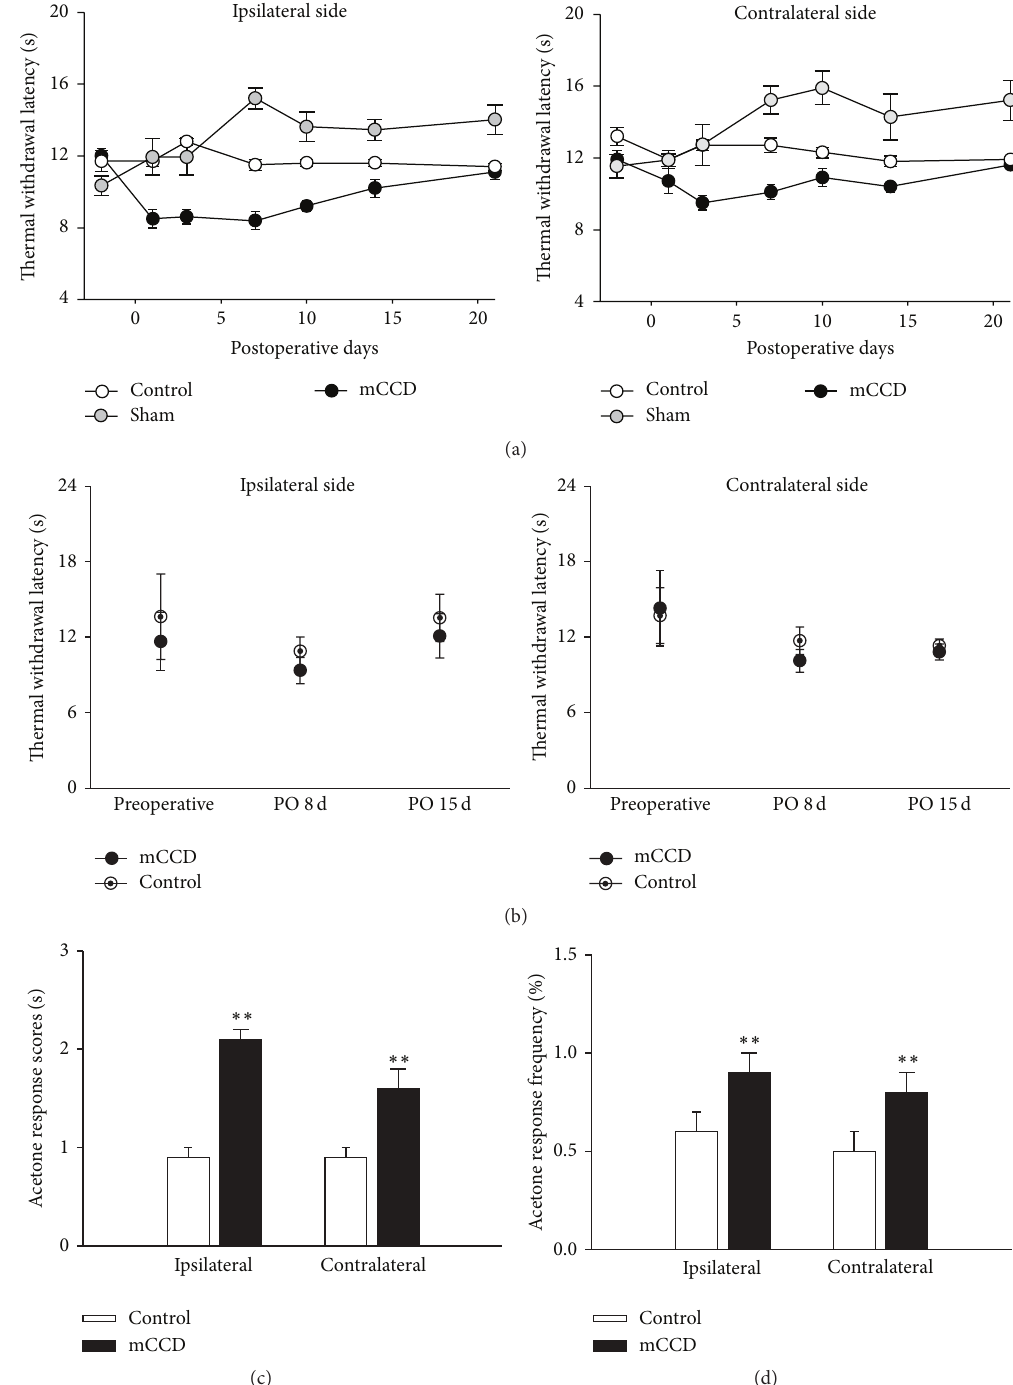
Figure 3: Thermal hyperalgesia and cold allodynic behaviors in the mCCD rat. (a) The time course of ipsilateral and contralateral hind paw withdrawal latencies to radiant thermal stimulation in mCCD ( 𝑛 = 8 ) and control rats ( 𝑛 = 8 ). Following the chronic compression of multiple DRGs, ipsilateral and contralateral hind paw withdrawal latencies were transiently decreased from the 1st postoperative day to postoperative day 21 compared to those of control groups (RM ANOVA, ipsilateral side: 𝑃 < 0.05 ; contralateral side: 𝑃 < 0.05 ). After 21 days, hind paw withdrawal latencies recovered to the baseline preoperative levels. (b) The time course of ipsilateral and contralateral forepaw withdrawal latencies to radiant thermal stimulation in mCCD ( 𝑛 = 4 ) and control rats ( 𝑛 = 4 ). No significant changes in either ipsilateral or contralateral forepaw withdrawal latencies in the mCCD rat (RM ANOVA, 𝑃 s > 0.05 ). (c) Response scores of the ipsilateral and contralateral hind paws to acetone in control ( 𝑛 = 23 ) and mCCD ( 𝑛 = 16 ) rats. Both ipsilateral and contralateral response scores to acetone increased after the chronic compression of multiple DRGs compared with the control group (one-way ANOVA followed by Bonferroni test, ipsilateral: 𝑃 < 0.001 ; contralateral: 𝑃 < 0.01 ). (d) Response frequencies of the ipsilateral and contralateral hind paws to acetone in control and mCCD rats. Cold allodynic response frequencies of both ipsilateral and contralateral hind paws were significantly increased in chronically compressed rats compared to that of the control group (one-way ANOVA followed by Bonferroni test, ipsilateral: 𝑃 < 0.01 ; contralateral: 𝑃 < 0.01